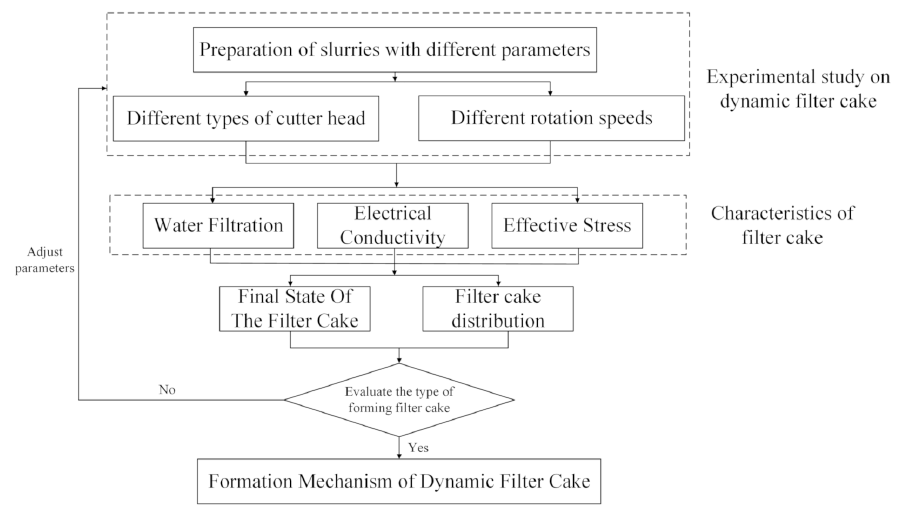
Figure 2. The experimental